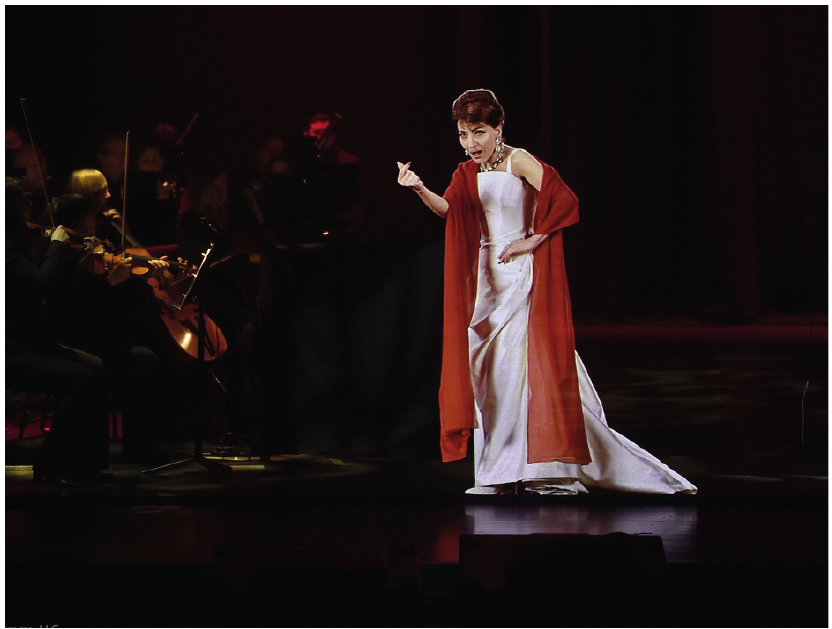
Fig. 1 The hologram of Maria Callas next to a live performing orchestra. (© Evan Agostini/Base